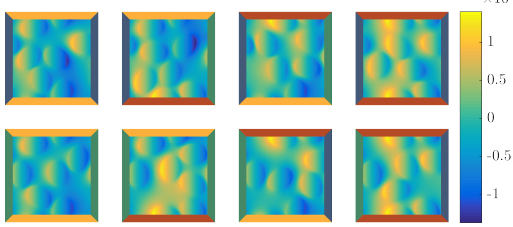
Figure 2. A compressed fluctuation field obtained by prescribing (S) variant of the second constraint and setting H = { 1 , 0 } T